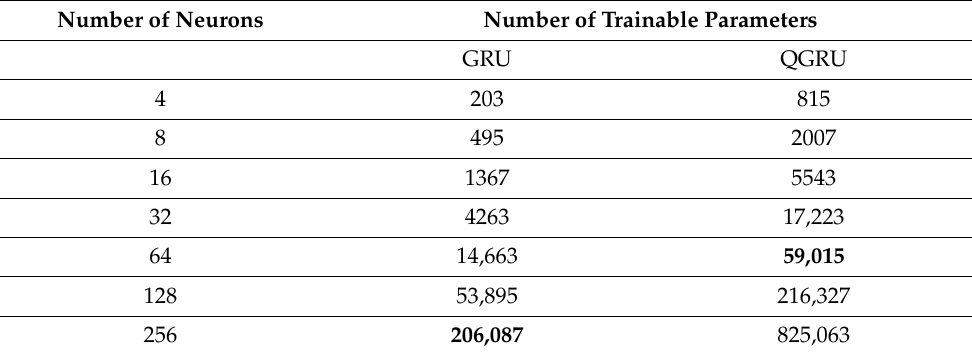
Table 5. The number of trainable parameters across various numbers of neurons used in the HAR task